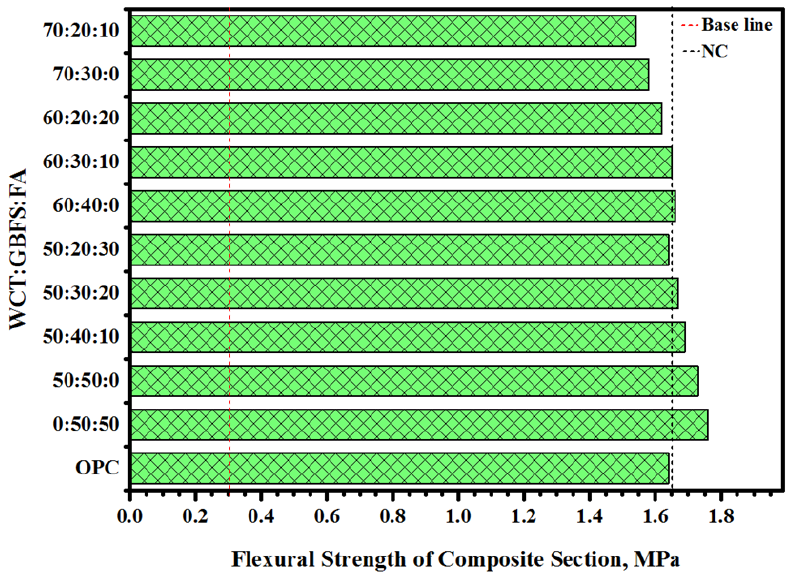
Figure 11. FS of composite beam prepared with various ratios of